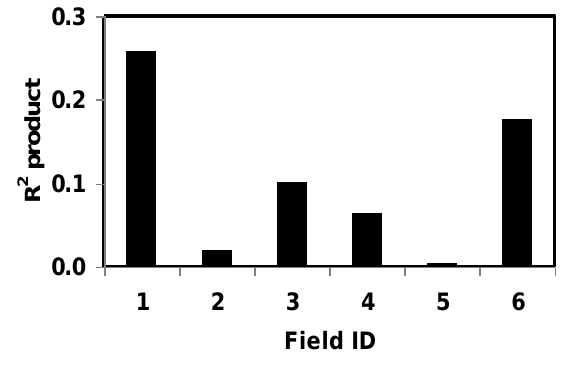
Figure 6. R 2 products for the six